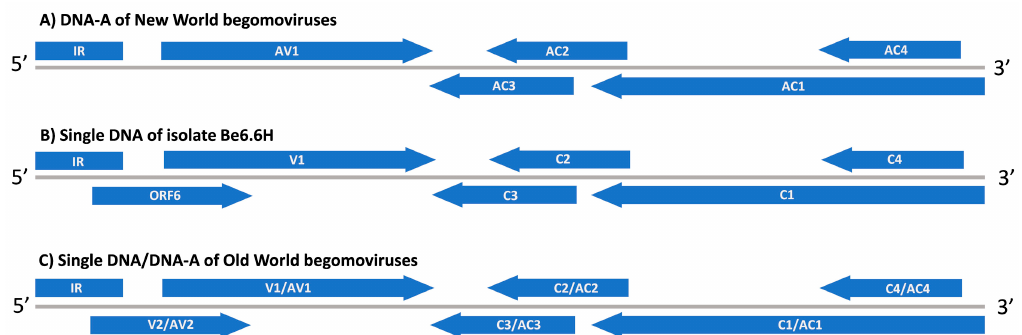
Figure 1. Genome organization of begomoviruses. ( A ) Typical genome organization of the DNA-A component from New World begomoviruses. ( B ) Genome organization of the clone Be6.6H displaying a sixth ORF encompassing the intergenic region (IR) and the V1 gene encoding the coat protein. ( C ) Typical genome organization of a single DNA or DNA-A component from monopartite and bipartite begomoviruses of the Old World. The gray lines represent the genome size of single DNA or DNA-A component of begomoviruses (ca. 2600–2800 bp). The arrowheads indicate the sense 5 (cid:48) –3 (cid:48) to each gene.